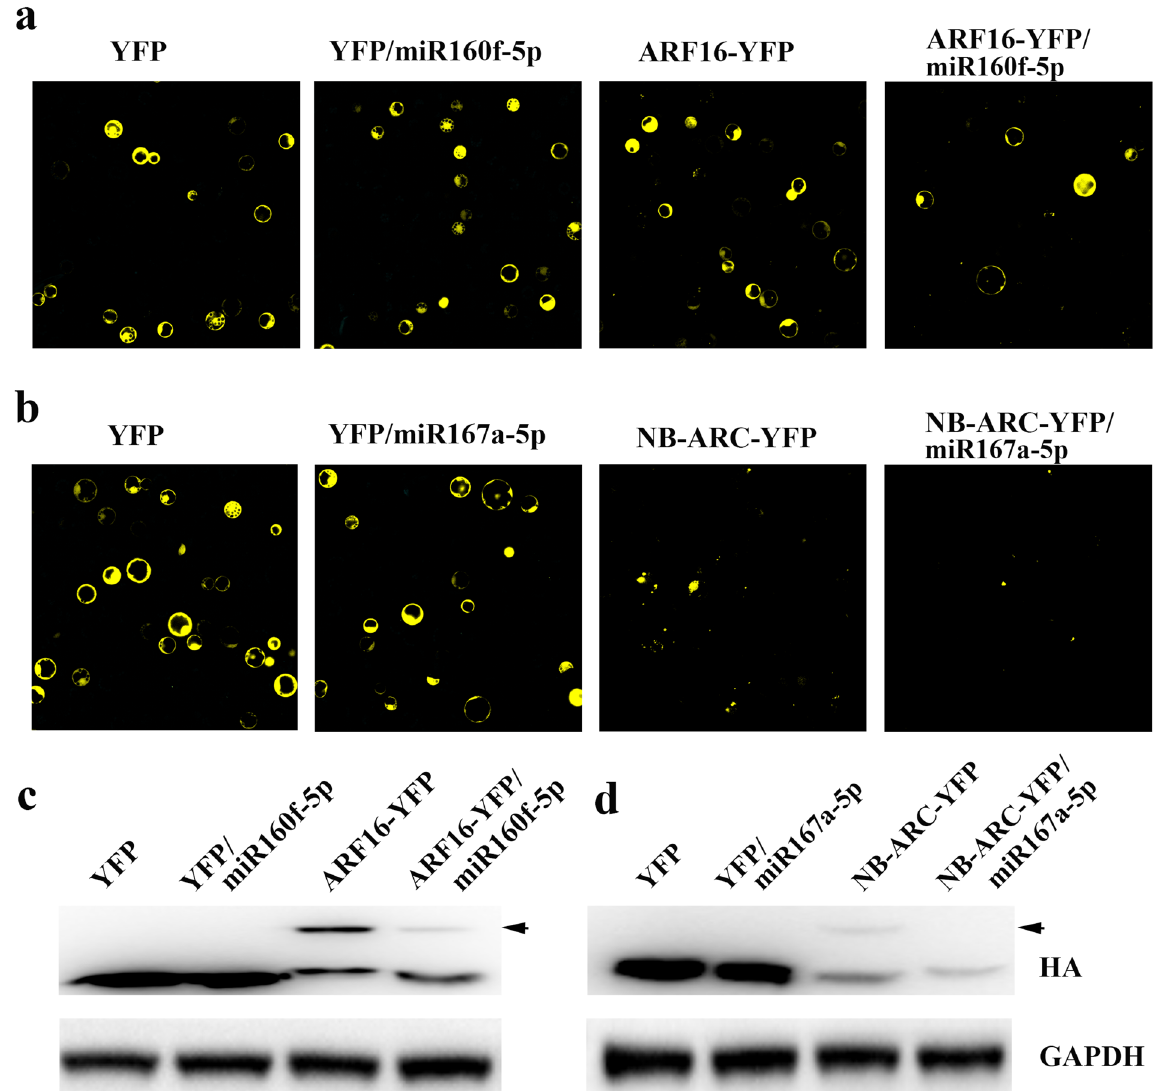
Figure 8. Target assay of effect of miRNAs on the predicted target gene expression in rice protoplasts. ( a ) Fluorescence micrographs of rice protoplasts transfected with YFP, YFP/miR160f-5p, ARF16-YFP and ARF16- YFP/miR160f-5p from left to right. The photographs were taken at 60 × magnification. ( b ) Fluorescence micrographs of rice protoplasts transfected with YFP, YFP/miR167a-5p, NB-ARC-YFP and NB-ARC-YFP/ miR167a-5p from left to right. The photographs were taken at 60 × magnification. ( c ) Western blot analysis of ARF16 expression or black plasmid expression in rice protoplasts transfected with YFP, YFP/miR160f-5p, ARF16-YFP and ARF16-YFP/miR160f-5p from left to right using anti-HA and anti-GAPDH antibodies. ARF16 is indicated with arrow. ( d ) Western blot analysis of NB-ARC expression or black plasmid expression in rice protoplasts transfected with YFP, YFP/miR167a-5p, NB-ARC-YFP and NB-ARC-YFP/miR167a-5p from left to right using anti-HA and anti-GAPDH antibodies. NB-ARC is indicated with arrow. The original blots of c and d are shown in Fig.